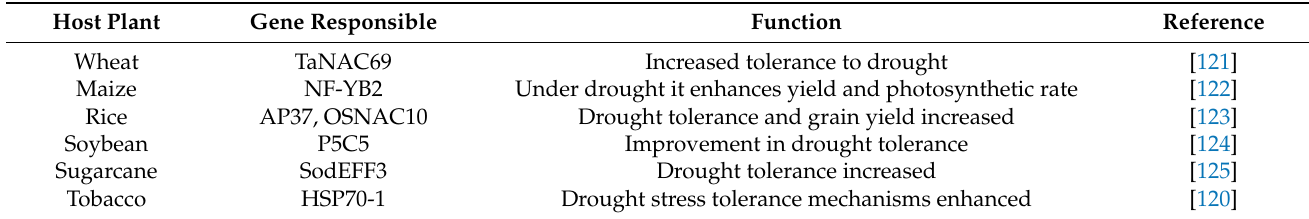
Table 1. Genes responsible for drought tolerance in